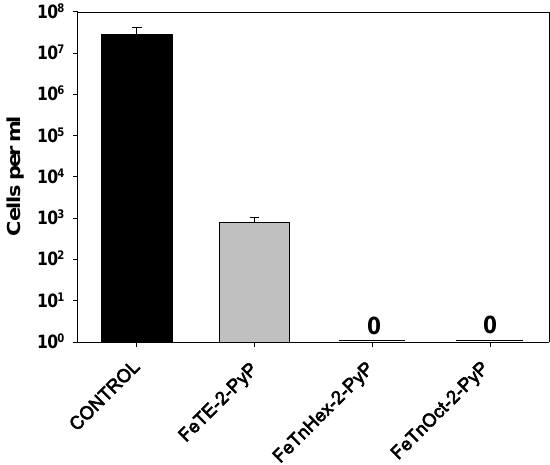
Figure 3. Bactericidal action of FePs. All conditions were as in Figure 2. After 24 h of monitoring growth, the content of wells with no increase in OD 600nm was evenly spread on agar plates and after 24 h of incubation at 37 °C, colonies were counted. The plates were left in the incubator for an additional 24 h and colonies were recounted. Control shows cell number at the beginning of the experiment (zero time). Results are presented as mean ± SD.